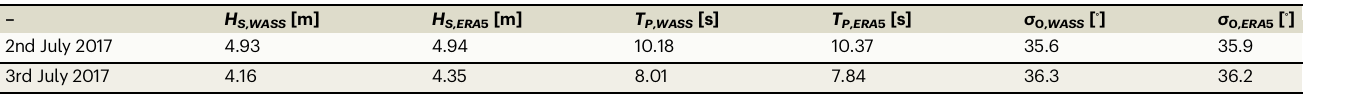
Table 1 | Integrated spectral wave parameters from our measurements and